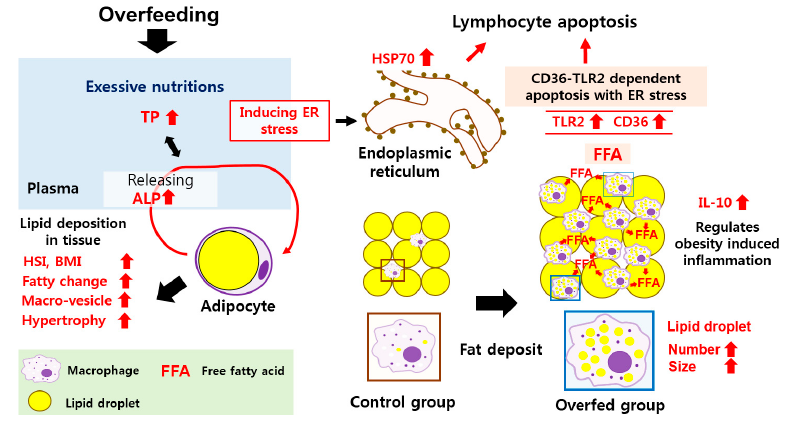
Figure 7. Schematic representation of the biological response of overfed rainbow trout.